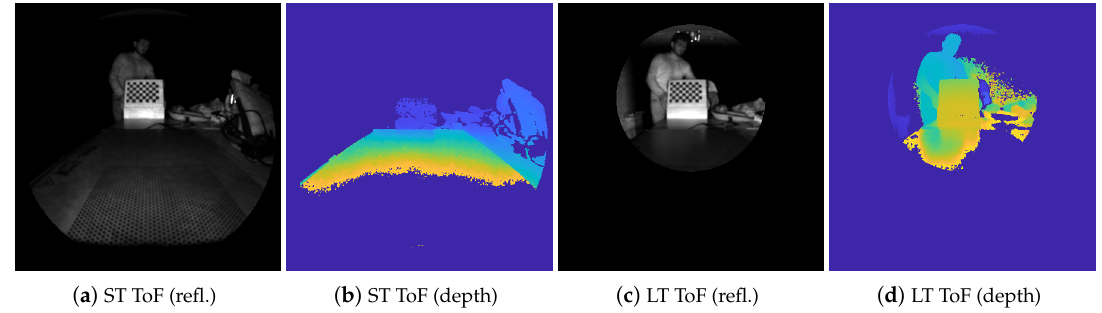
Figure 5. Example frames from HoloLens’ ToF depth camera. The sensor acquires 450 × 448 depth and reflectivity maps, in short-throw (ST), i.e., up to ∼ 1 m, and long-throw (LT), i.e., up to ∼ 3 m.